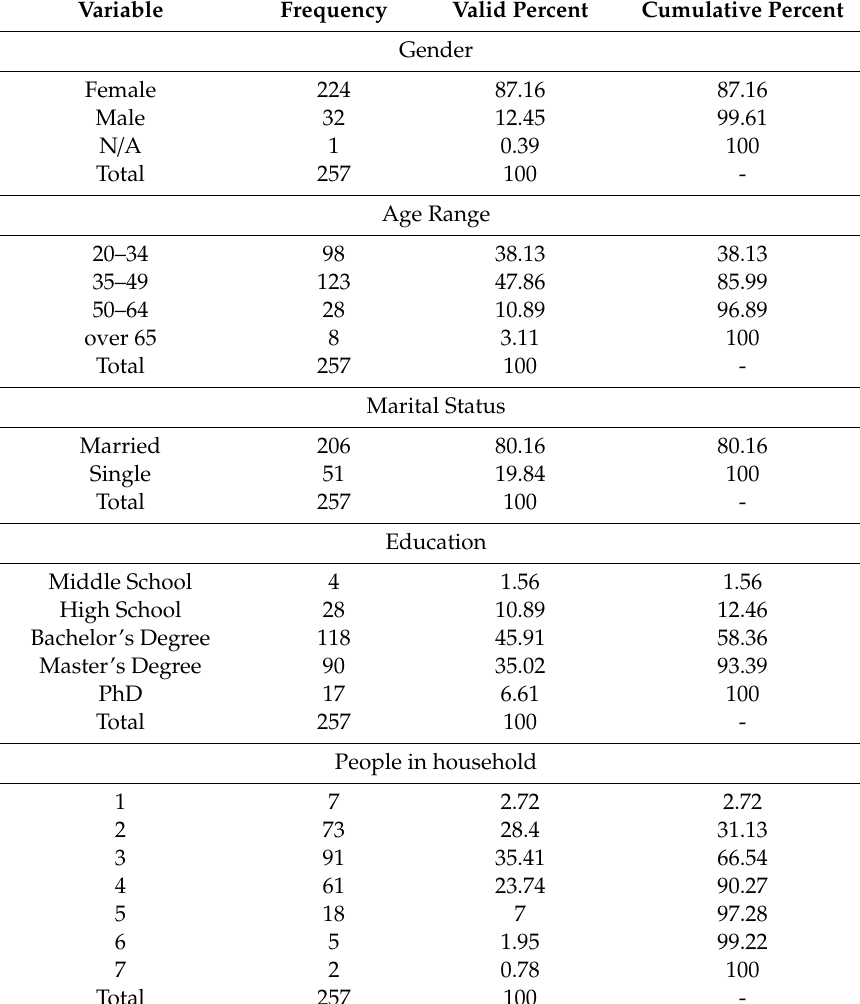
Table 2. Frequency distribution table for the social demographics of the